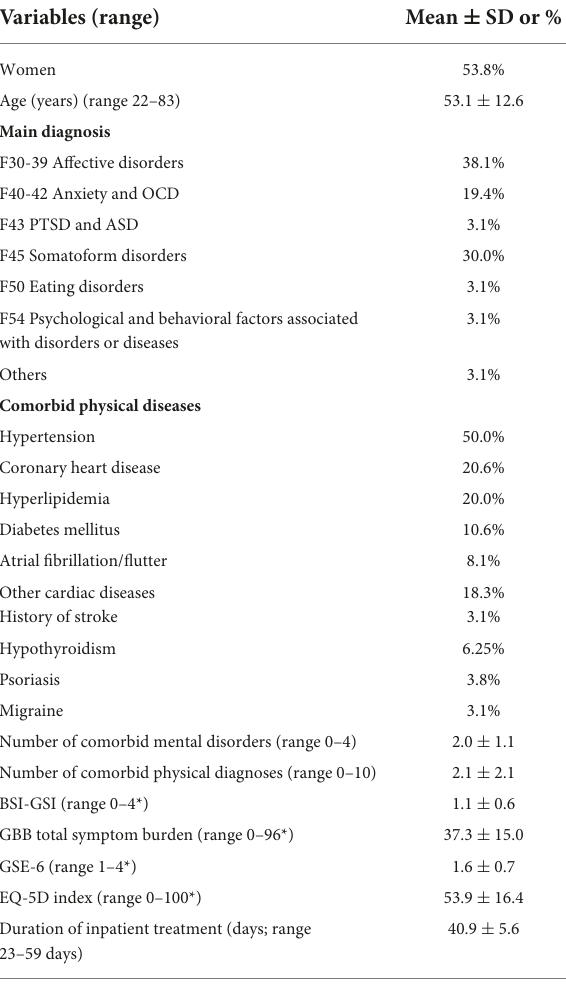
TABLE 1 Characteristics of clinical and psychological